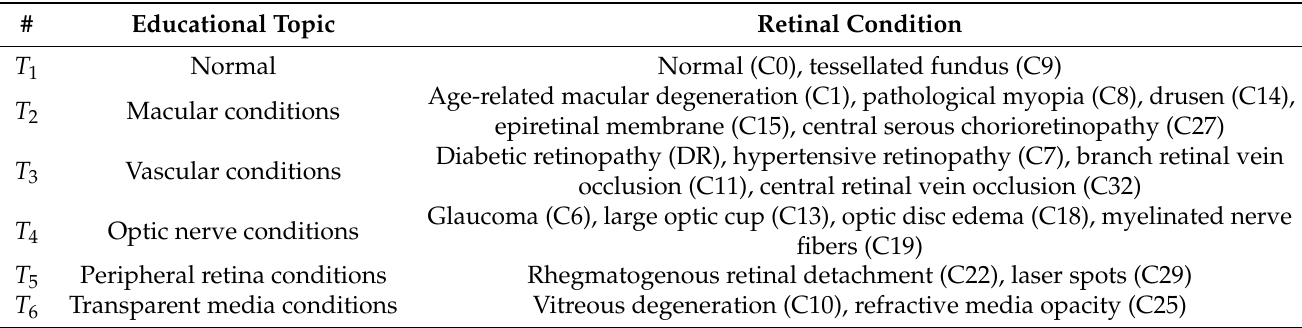
Table 5. Educational topics in the retina study